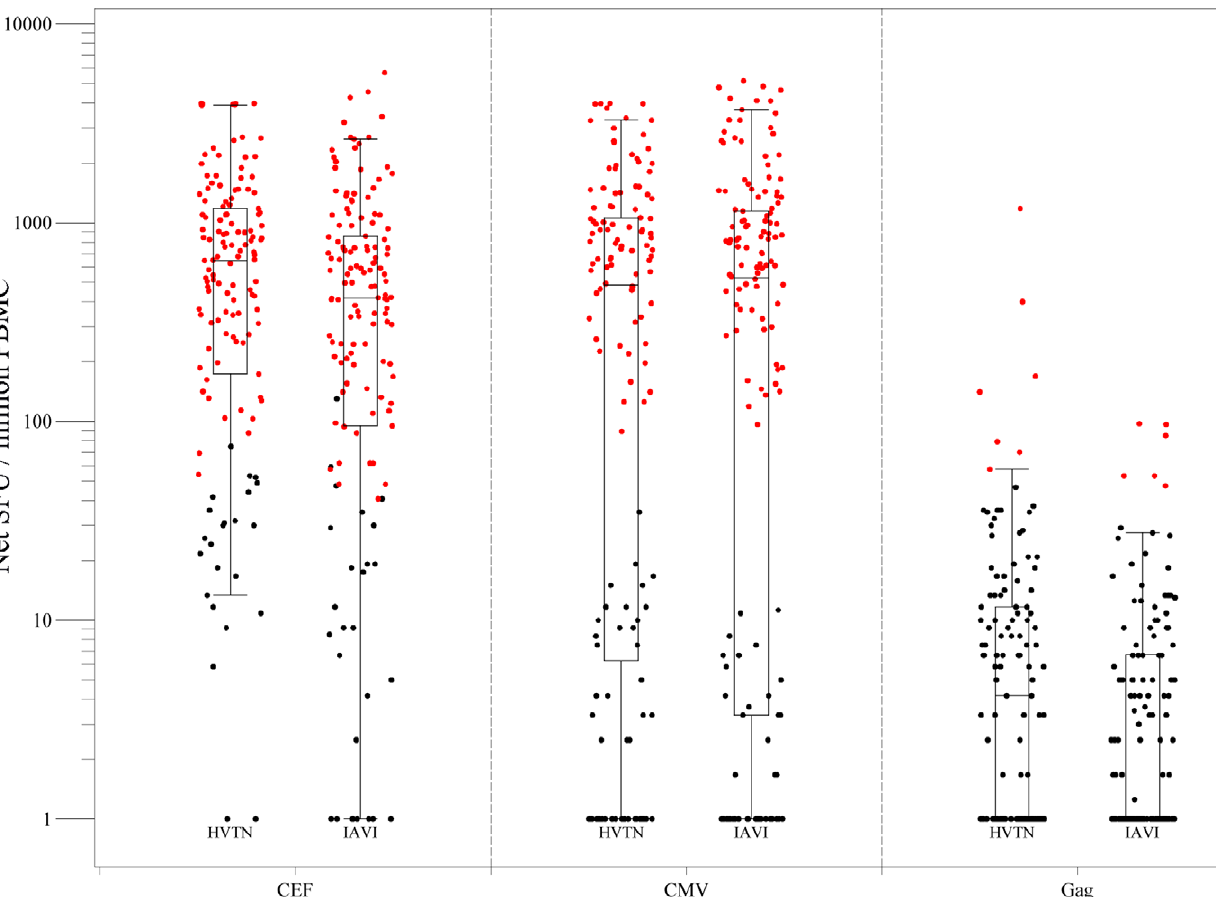
Figure 2. Boxplots of net IFN-g ELISpot responses from the inter-laboratory comparison study. Boxes represent the inter-quartile range of 25–75 th percentiles, the whiskers extend to the most extreme data point which is no more than 1.5 times the inter-quartile range from the box. The color of the dots indicate the positivity of the actual responses (red for positive and black for negative) determined by the positivity criteria described in section 4.5. SFU=spot forming units.